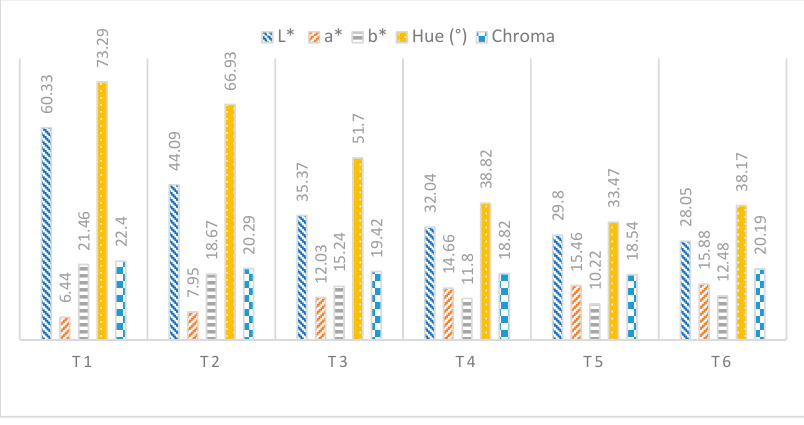
Figure 2. Color Scores of Ready-to-cook Gluten-free Snacks.